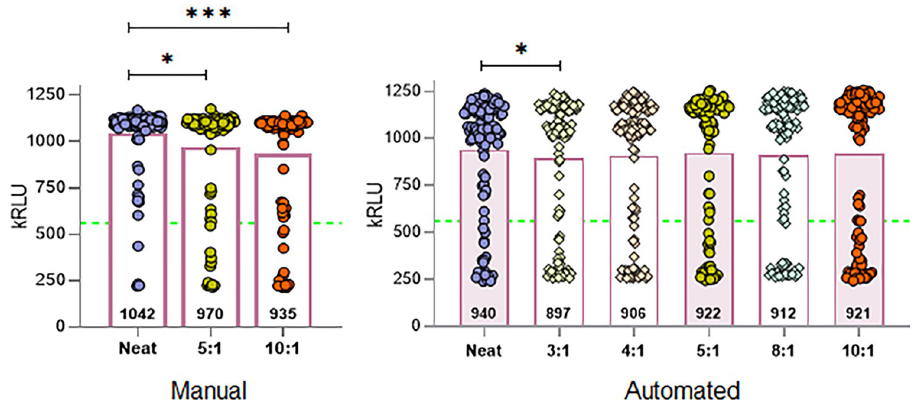
Fig 2. Distribution of Aptima 1 pooled sample test results. Samples used in manual (left panel) and automated (right panel) pool generation. Test results are represented as circles. Numbers within bars represent median values. Dashed horizontal line represents cut-off value (560 kRLU). Two-sided t-test, � p < 0.03, ��� p < 0.0001.